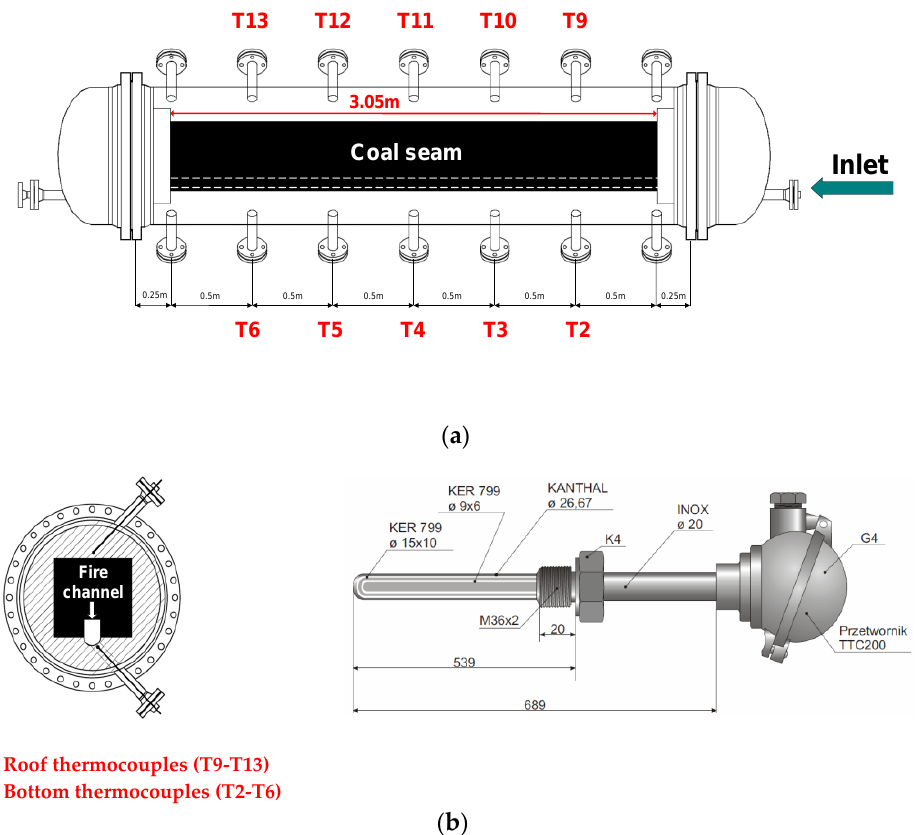
Figure 2. Cross sections of the ex-situ reactor prepared for UCG tests: ( a ) side cross-section, ( b ) vertical cross-section [30]. Reproduced from [30], Elsevier: 2019 Distribution of temperatures during the gasification process was controlled by 10 high temperature thermocouples (Pt10Rh–Pt). The left side of Figure 2b shows vertical cross-section of the reactor. It can be seen, that the thermocouples are located in the insulating layer of the reactor and do not reach the coal seam. Such location of the thermocouples is necessary to protect them from direct contact with oxidizers. The distance of the thermocouples from the bottom and roof of the artificial seam was about 2 cm.